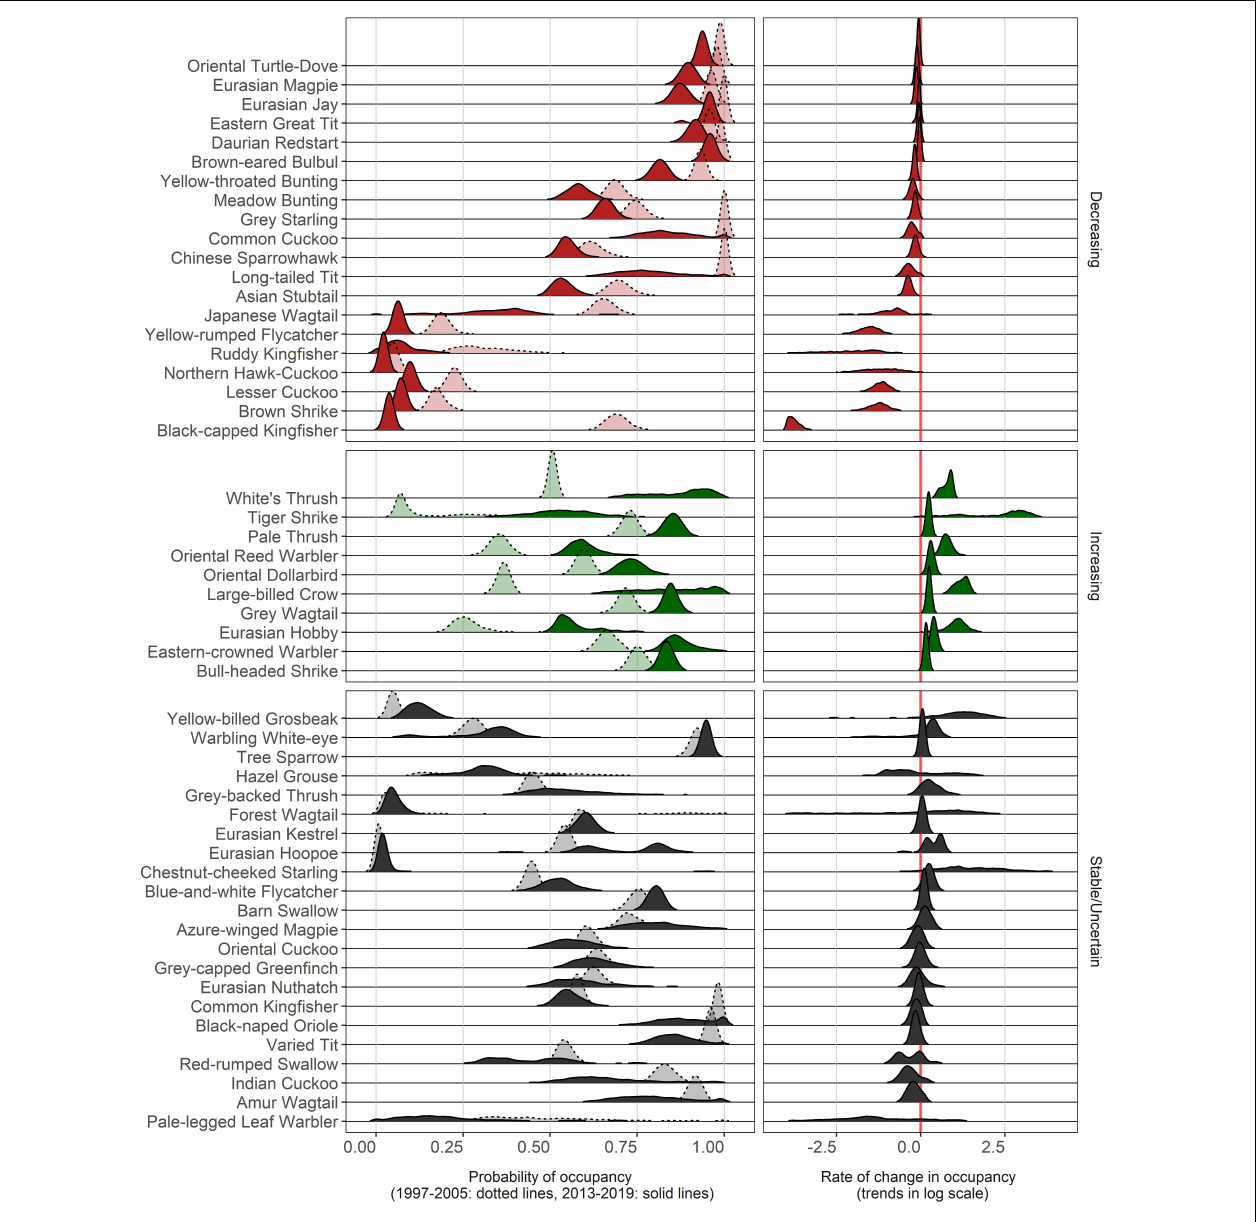
FIGURE 2 | Distribution of bootstrapped parameter estimates of the probability of occupancy (occurrence) of each species in 1997–2005 (dotted line) and 2013–2019 (solid line) period and rate of change between the two periods. Species are ordered by the magnitude of change from low to high. Each density distribution can be used to understand the uncertainty of estimates (more uncertainty when it is flat and wide, for average occupancies and trend parameters). Note that the rate of change is log-transformed with two base. Thus, one unit change refers to a two-fold change in the probability of occupancy.